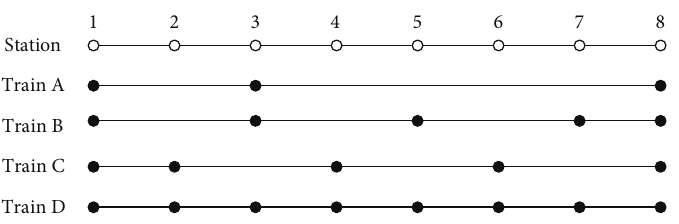
Figure 1: The train service network. k